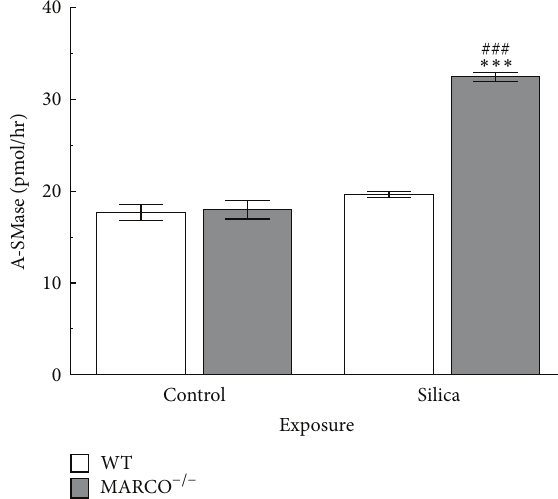
Figure 7: Effect of silica on acid sphingomyelinase activity. Acid sphingomyelinase activity in WT and MARCO −/− AM, 1hr after treatment with silica (100 𝜇 g/mL). White bars indicate WT AM and grey bars indicate MARCO −/− AM. Triple asterisk ∗∗∗ indicates 𝑃 < 0.001 compared to WT at corresponding treatment. ### indicates 𝑃 < 0.001 compared to control at the corresponding mouse strain, 𝑛 = 3 per experimental